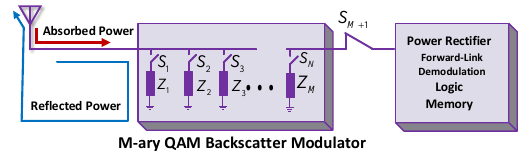
Figure 23. Quadrature amplitude modulation (QAM) in BackCom.